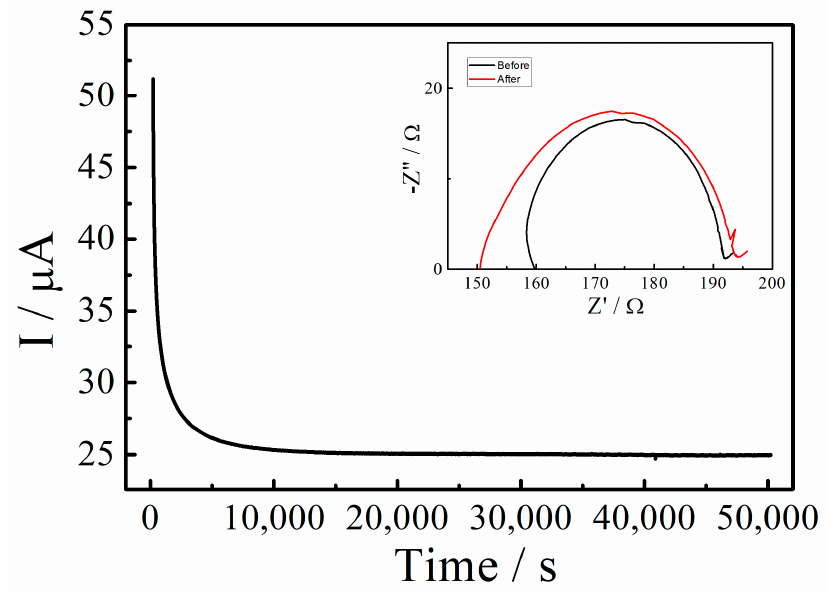
Figure 5. Chronoamperometry of the Li/GE/Li symmetrical cell at 25 °C. The inset shows the AC impedance spectra before and after polarization.